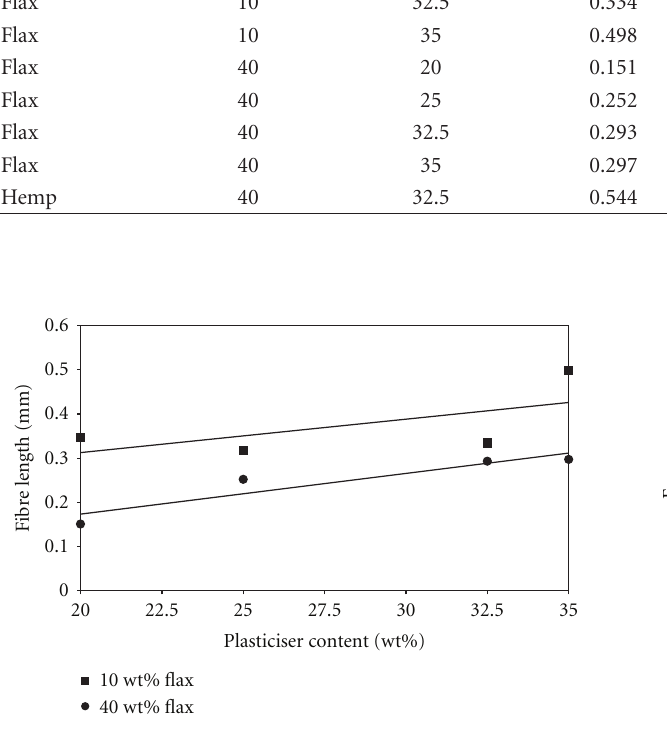
Figure 3: Comparison of fiber length distributions of fully processed hemp and flax